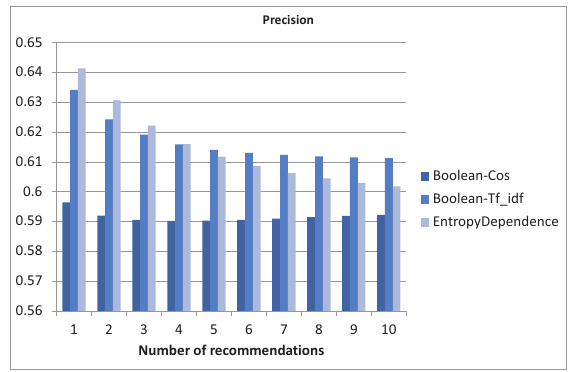
Fig. 2. Precision of the algorithms according to number of recom- mendations